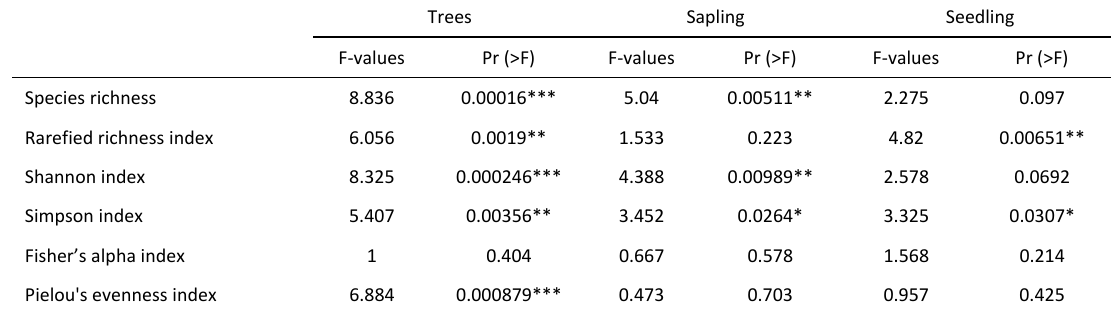
Table 2: F‐values of multivariate diversity at different growth stages and peat depths. Table 2: F-values of multivariate diversity at different growth stages and peat depths.